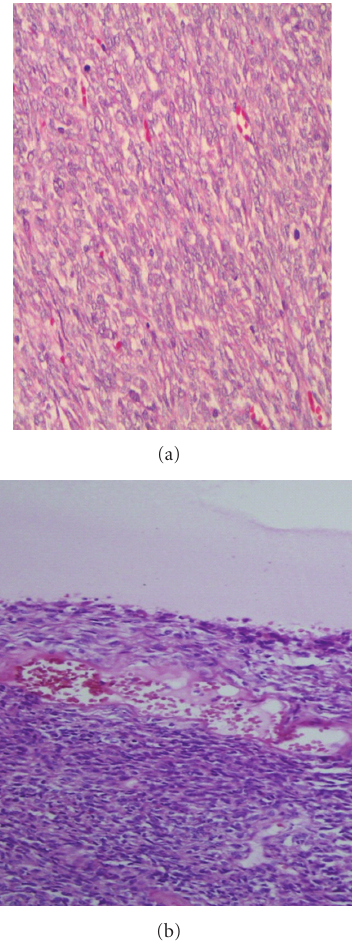
Figure 2: Macroscopic views of the case